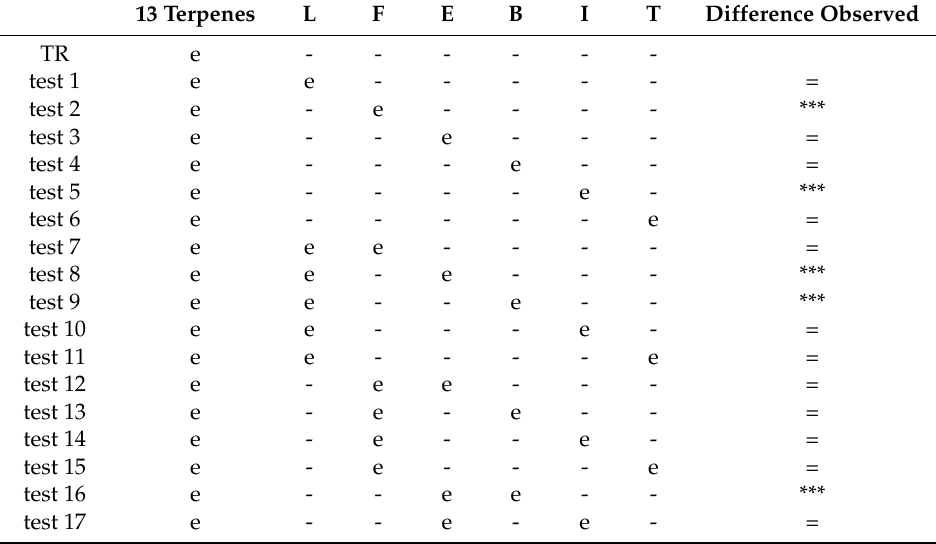
Table 3. Sensory effect of the addition of alcohols in terpenes